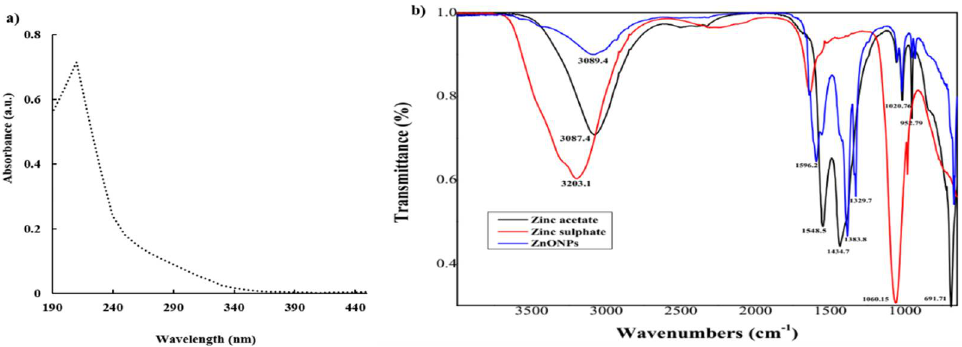
Figure 3. Spectroscopy characterization of ZnONPs. ( a ) UV-Vis absorption peak of ZnONPs, ( b ) FT-IR spectra of ZnONPs and the salt precursors showing variation in the chemical functional groups on formation of ZnONPs from the precursor salt.